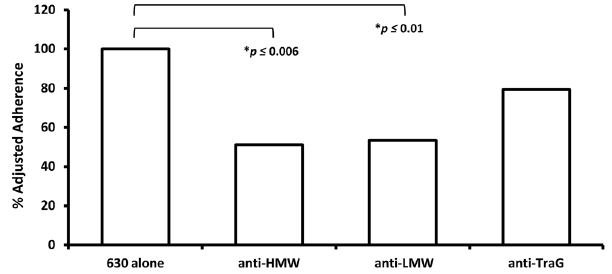
Figure 8. C.difficile adherence is inhibited by pre-incubating bacteria with anti-SlpA antiserum. C. difficile strain 630 incubated with a 1:1000 dilution of non-specific or specific (anti-SlpA) antiserum prior to association with C2 BBE host cells. For comparative purposes, data were converted to percent-adjusted adherence, with adherence of the control (no added antiserum) set to 100%; therefore no error bars appear. Means of three replicates are shown. Anti-TraG antiserum (an unrelated protein from Bacteroides sp) was used as a negative control.